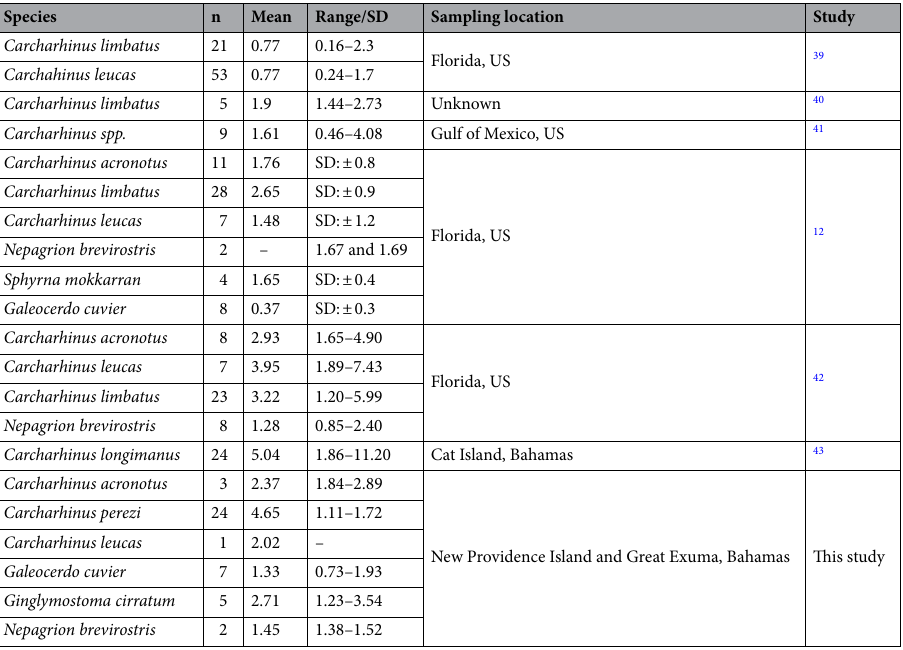
Table 2. Summary of literature-derived total mercury (THg) concentrations (mg kg −1 , wet weight) reported for shark muscle tissue in species typically found throughout The Bahamas and neighboring regions (updated and adapted from Matulik et al. 2017). Concentrations for sharks captured in this study were converted to wet weight by multiplying dry weight concentrations by 0.3 assuming a ~ 70% moisture content reported for shark muscle tissue 44